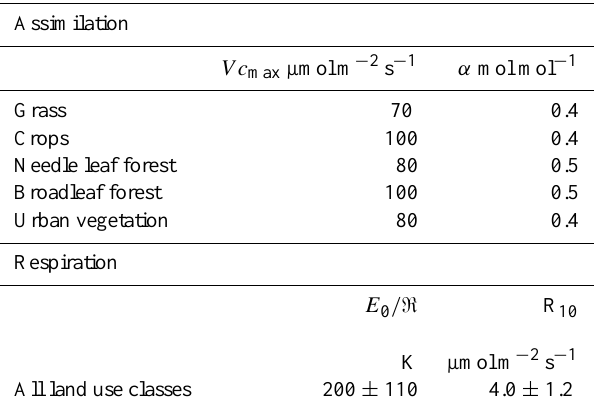
Table B1. Prior values of the parameters in the biosphere model for the different land use